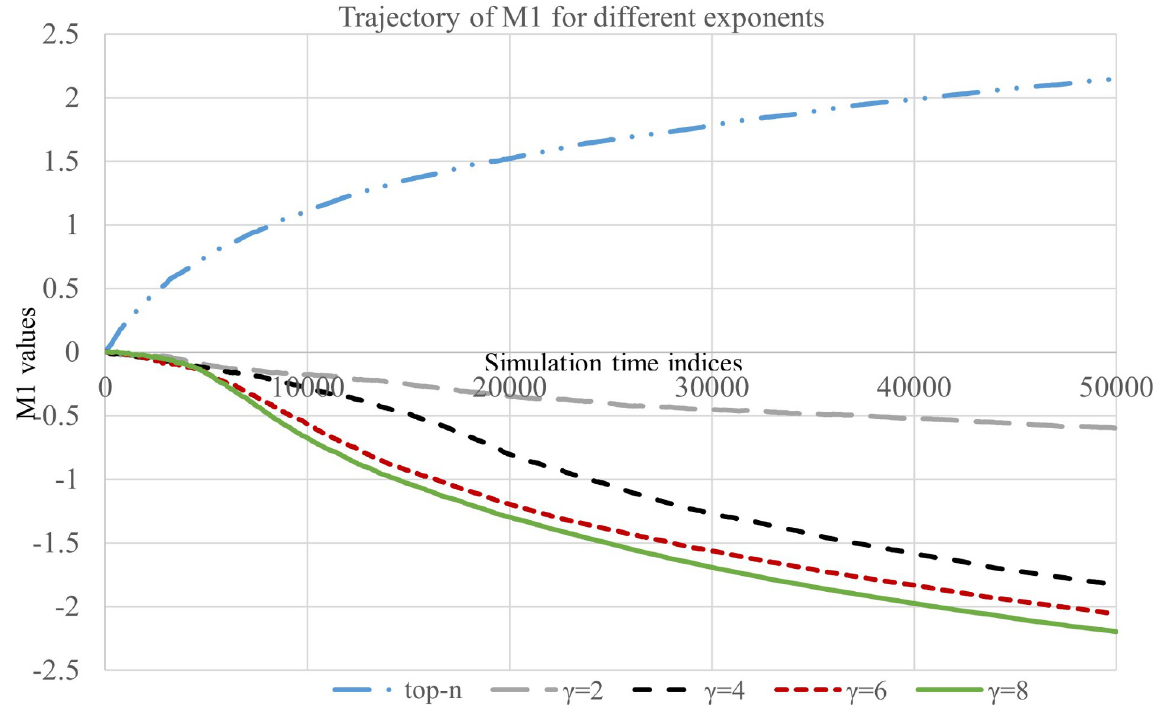
Fig 2. Boundary amplification of